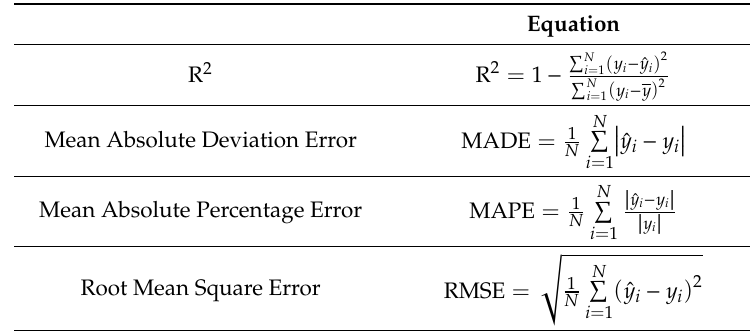
Table 3. Goodness of the measures.